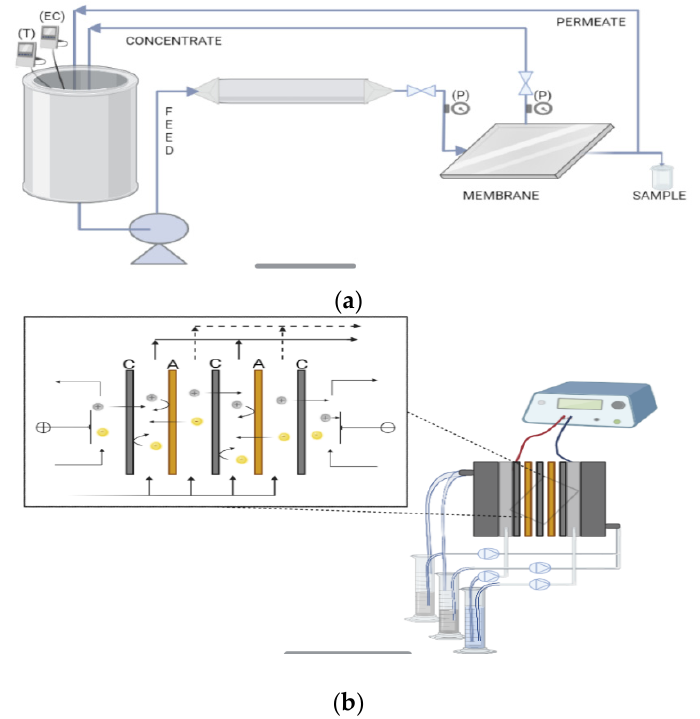
Figure 2. Diagram of ( a ) NF system (T, temperature; EC, electric conductivity; P, pressure) and ( b ) ED system (C, cation-exchange membranes; A, anion-exchange membranes).